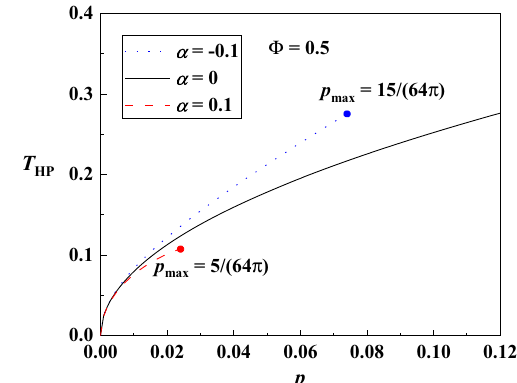
Fig. 10 The Gibbs free energy of large RN–AdS black holes as a func- tion of temperature, with Φ = 0 . 5, p = 1 /( 48 π) , and different values of α . All the G – T curves start from the same minimal temperature √ T 0 = 1 /( 4 2 π) , analogous to the Schwarzschild–AdS case in Fig.